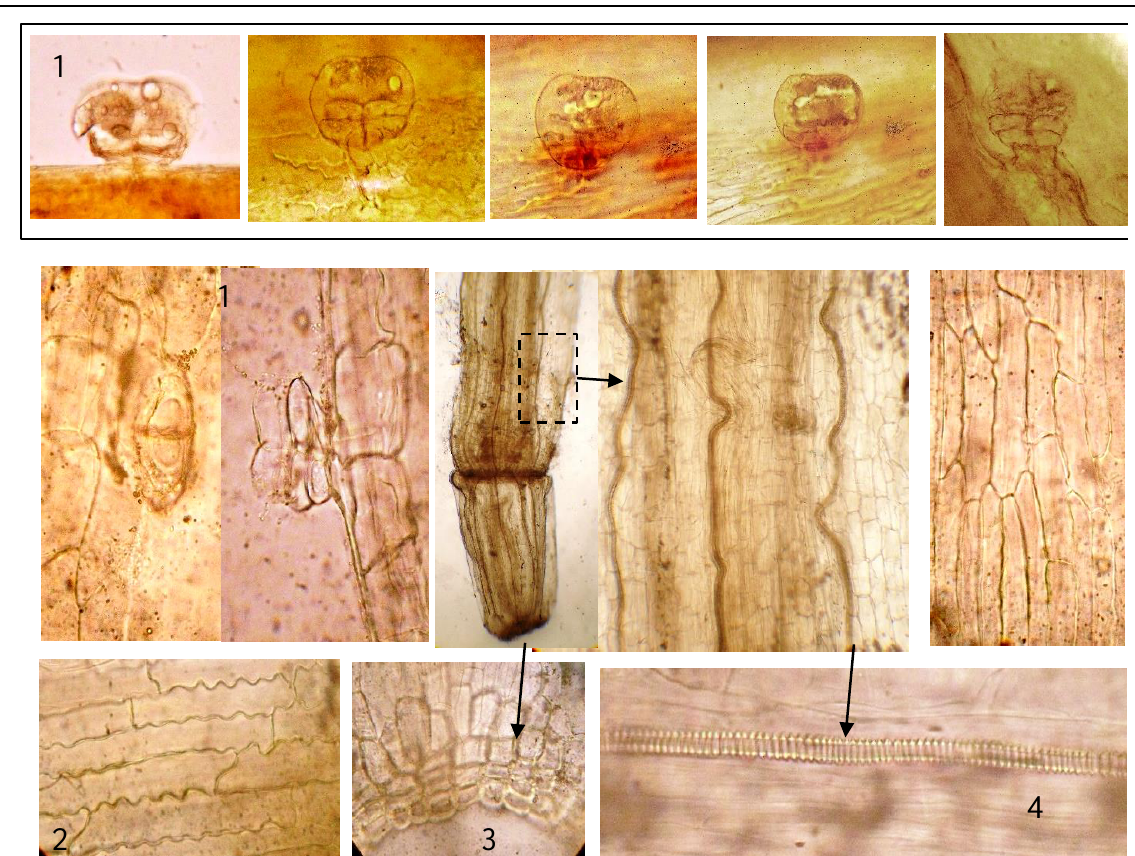
Fig. 4. Fragments of surface preparations of the tube of middle flowers: 1 – essential oil glands; 2 – epidermis of the tube; 3 – sclerified cells of the basal part of the flower; 4 – spiral vessel of the vein